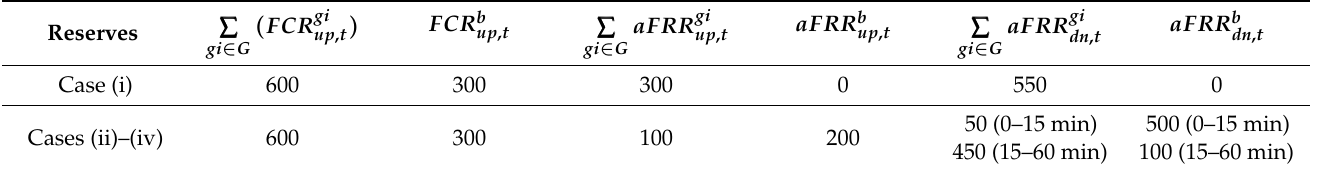
Figure 8. Response following a diesel unit outage at 150 s and synchronization of another unit at 900 s, for the different regulation methods of cases (i)–(iv). ( a ) Frequency, ( b ) BESS active output power (positive: injection, negative: absorption), ( c ) diesel units’ (DUs) aggregate active power, ( d ) SOC, ( e ) DUs’ automatic frequency restoration reserve (aFRR)-up participation factor, ( f ) BESS aFRR-up participation factor. Table 1. Allocation of system reserves (in kW) to DUs and